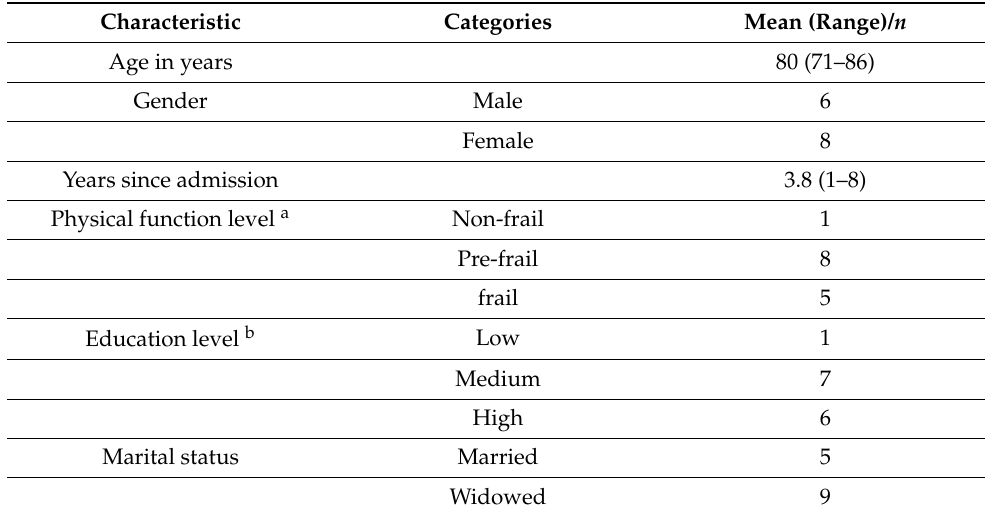
Table 2. Characteristics of the research population (N =